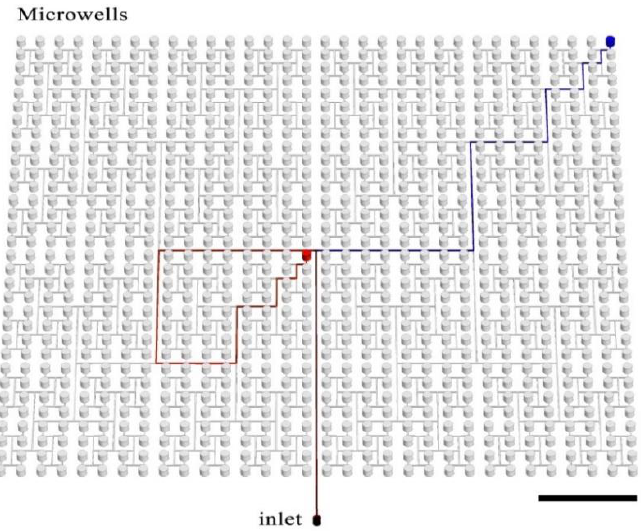
Figure 1. Schematic architecture of the fractal microwell array. Grid of microwells, which are connected by a network of branched microchannels. We highlight the two paths the fluid takes to fill two microwells with colored lines in order to show that all paths to all microwells are hydraulically equivalent. The scale bar is 1 cm.